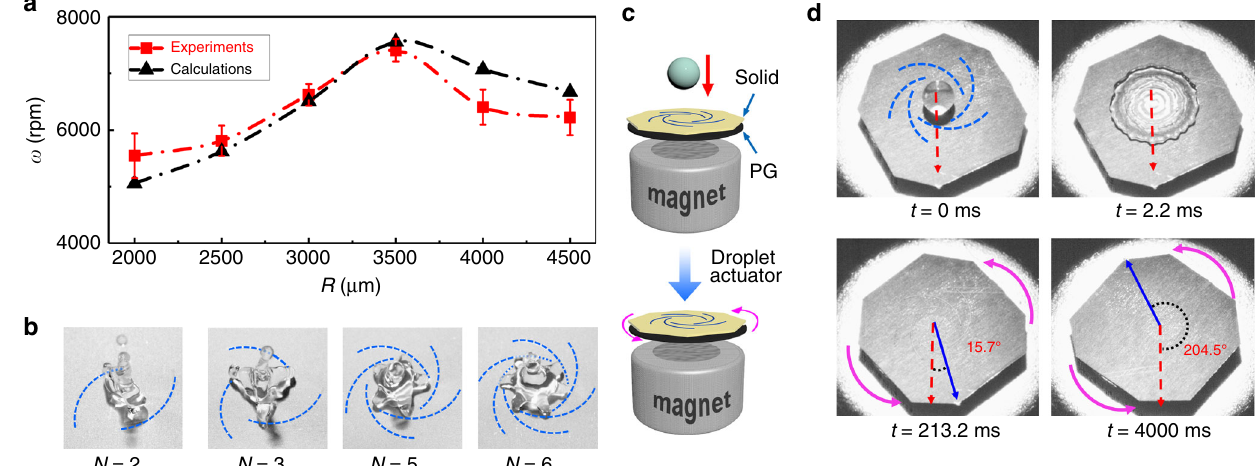
Fig. 3 Droplet movement regulation and solid actuation. a Dependence of the instantaneous rotational speed of the droplet ( ω ) on the radius of the spiral ( R ). In these tests, the Weber number of the droplet is 93. b Various morphologies of the gyrating droplets by impacting on high-adhesive patterns with different spiral numbers N of 2, 3, 5, and 6, respectively. c Scheme of the droplet actuator where a chemically heterogeneous thin solid sitting on a magnetically-levitated pyrolytic graphite (PG) fl ake. Water droplet is released and impacts on the center of the solid. d Sequenced images to show a water droplet (4.8 mg in mass) impacting on the PG-supported heterogeneous solid (94.3 mg in total mass). The substrate is driven to rotate in a desirable direction for more than 8000 ms. The Weber number of the droplet is 93. The thicknesses of the PG fl ake and the patterned solid are 0.5 mm and 50 μ m, respectively. In b and d , the blue dashed arcs represent the high-adhesive pattern on the low-adhesive